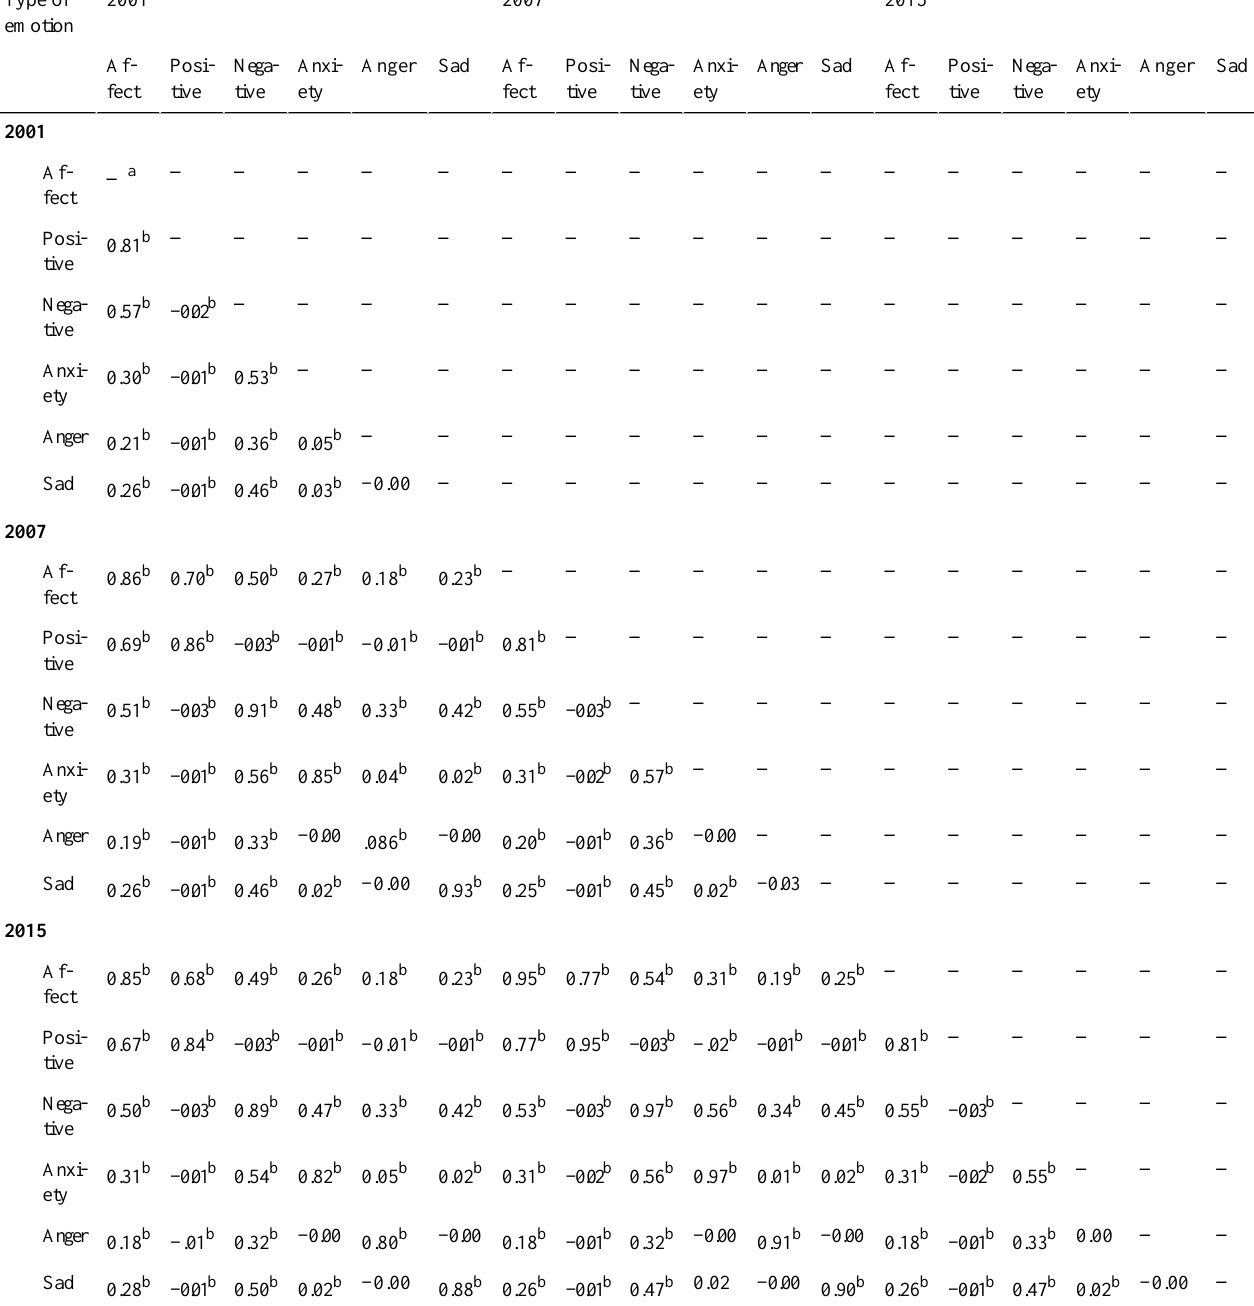
Table 3. Correlation matrix comparing Linguistic Inquiry and Word Count 2001, 2007, and